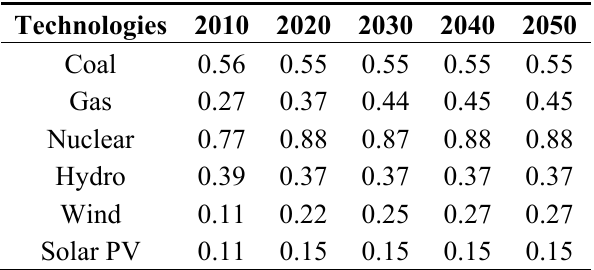
Table 10. Load factors for technologies during the projected period.